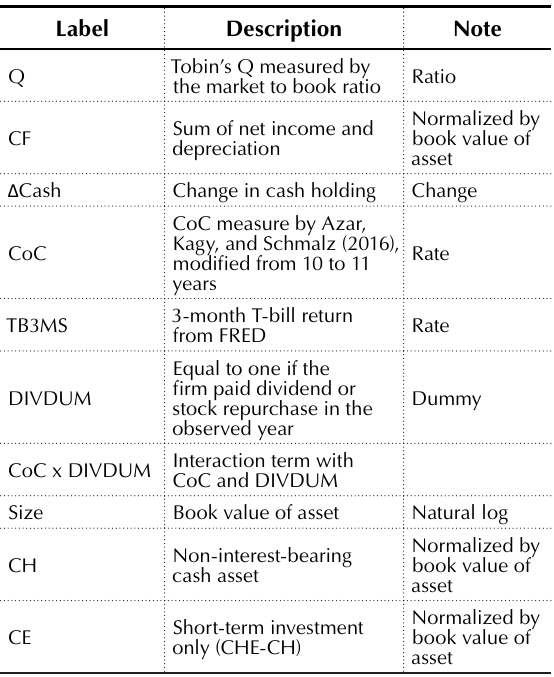
Table 1. Description of